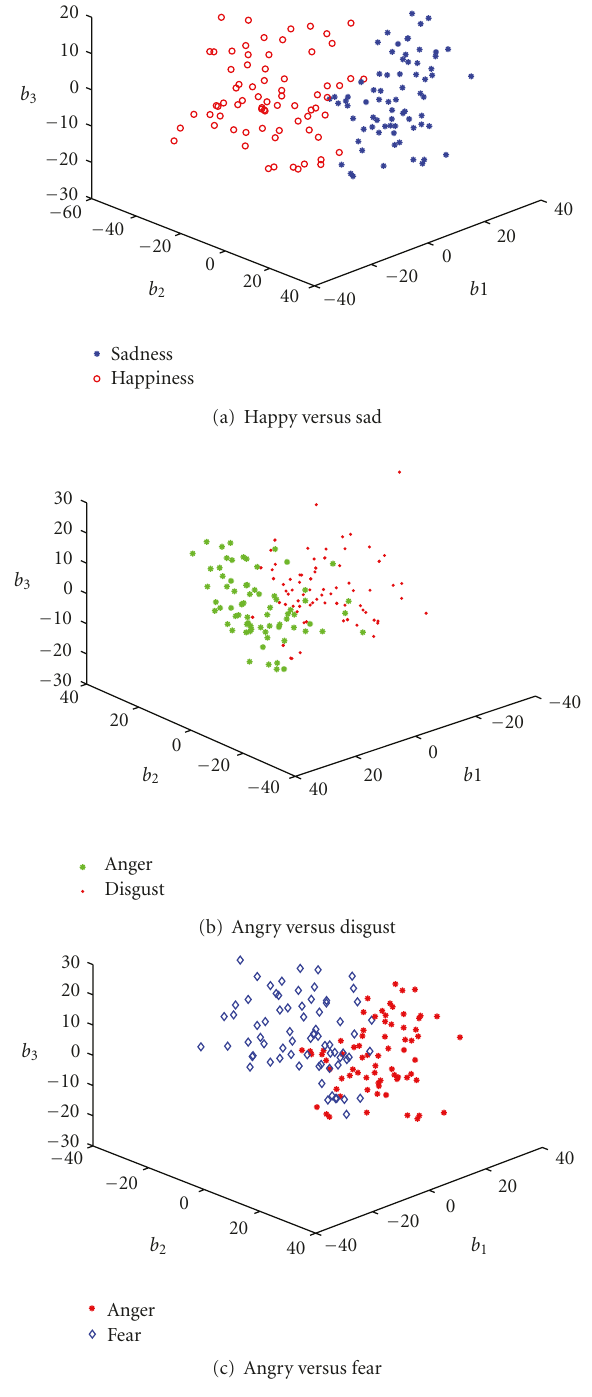
Figure 10: Separability analysis for automatically selected land- marks using first three principal